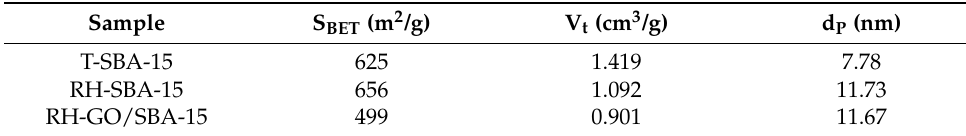
Figure 7. Nitrogen sorption isotherms and pore size distributions: ( a , b ) T-SBA-15; ( c , d ) RH-SBA-15 and RH-GO/SBA-15. Table 2. Surface area, pore volume and pore diameter of adsorbent